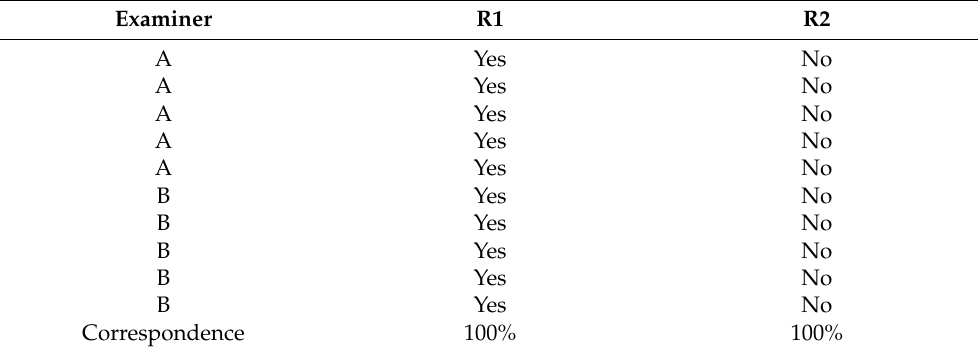
Table 5. Reproducibility of IHC examination by different examiners.